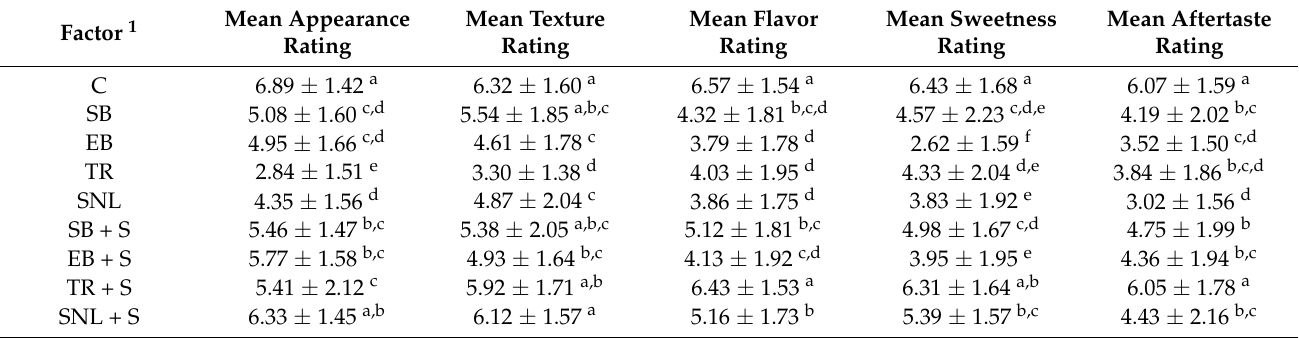
Table 8. Means and standard deviations for hedonic ratings (out of nine) of sensory attributes for each